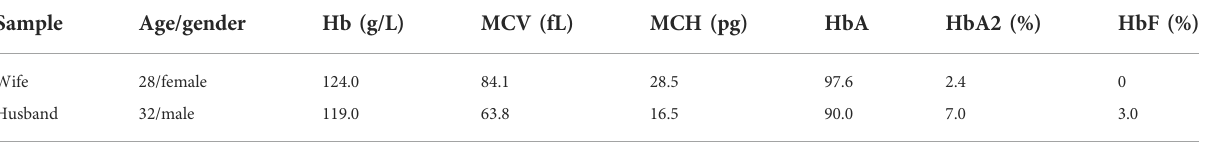
TABLE 1 Hematological features, Hb electrophoresis of the couple.